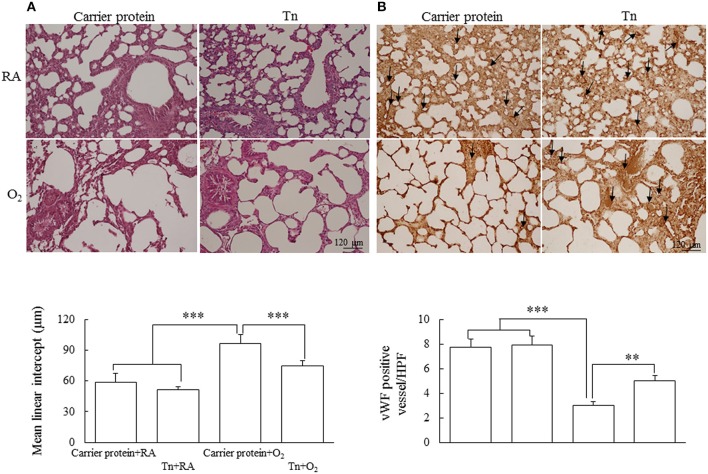
Representative H&E stained lung sections for histology observation and (A) mean linear intercept assessment and (B) immunohistochemistry of vWF and semiquantitative analysis for vascular density in lung of 14-day-old rats in the carrier protein + RA, Tn vaccine + RA, carrier protein + O2, or Tn vaccine + O2 group. The rats in the carrier protein + O2 group exhibited a significantly higher MLI and lower vascular density than those in the carrier protein + RA or Tn vaccine + RA group. Maternal Tn immunization reversed the MLI and vascular density to normoxic levels. **p < 0.01, ***p < 0.001.